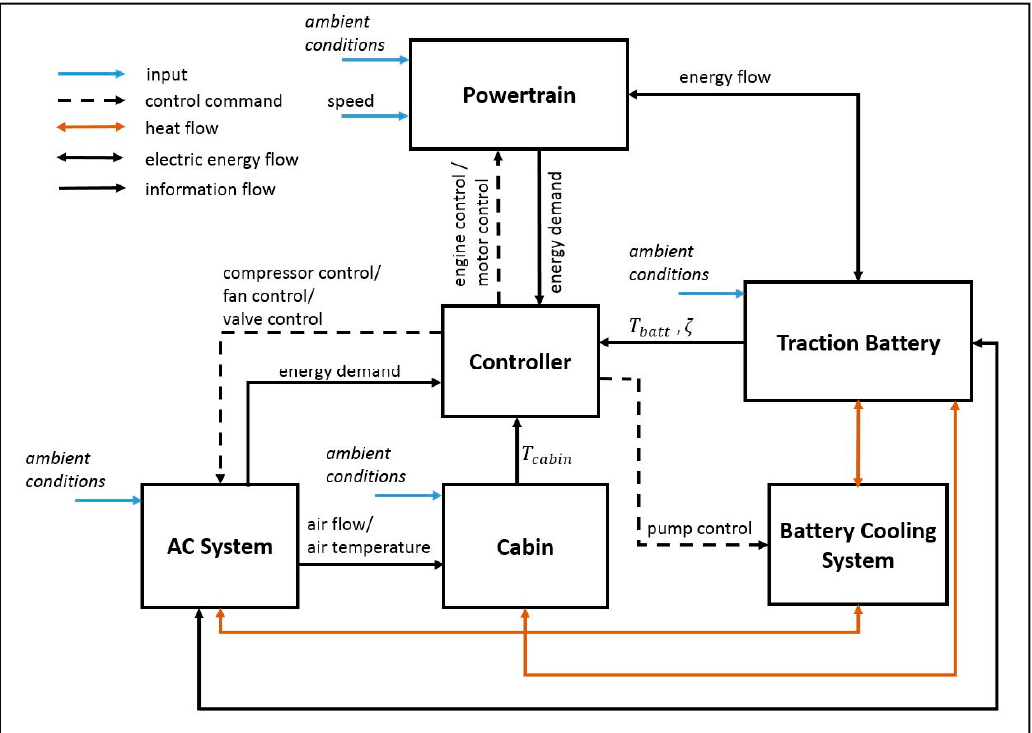
Figure 3. Vehicle model layout.